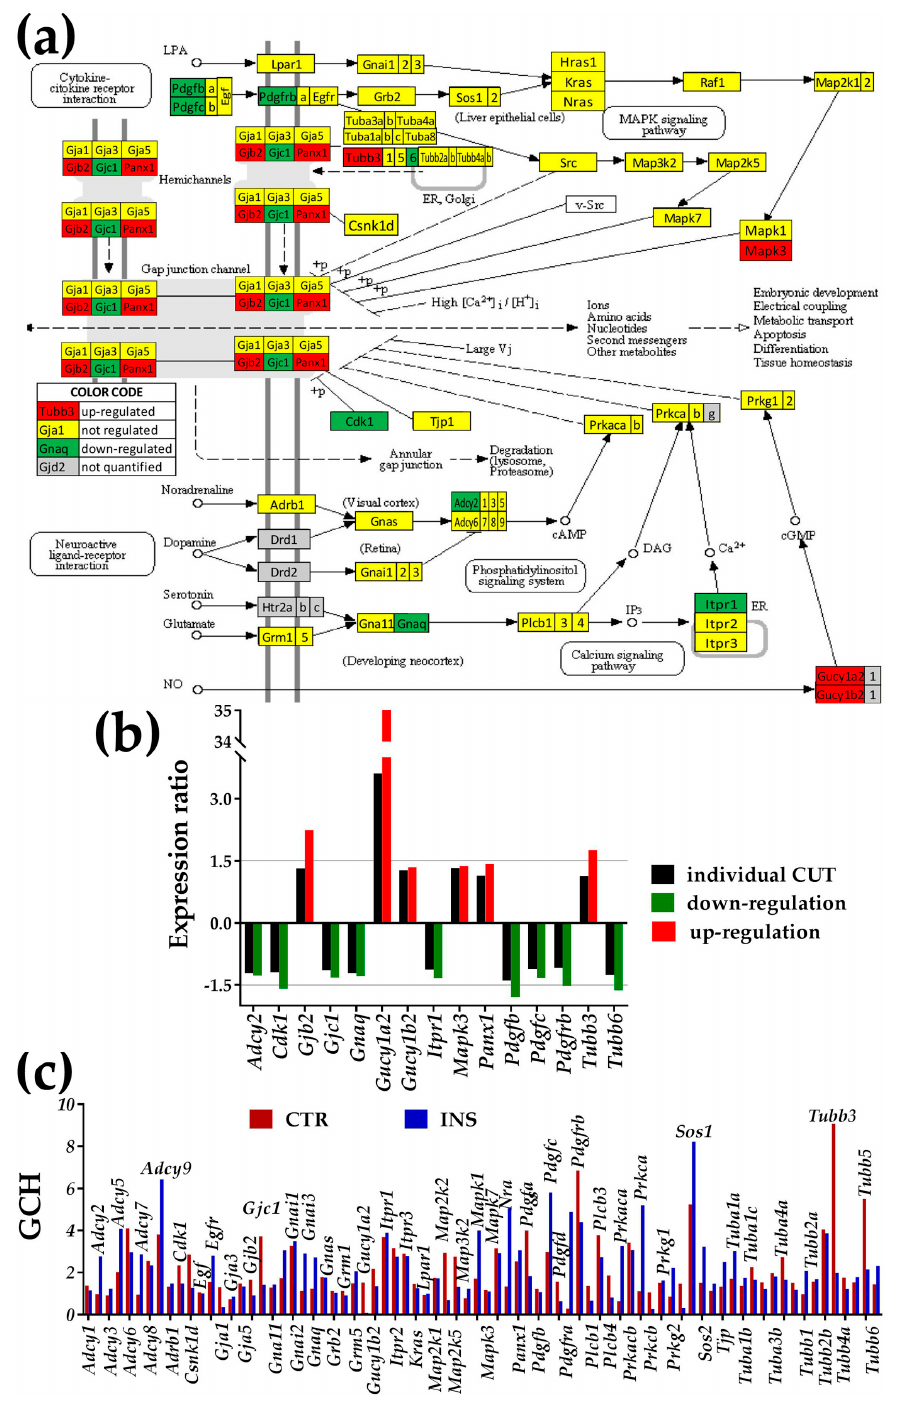
Figure 2. Presence of non-touching Oli-neu cells affects genes in the gap junction (GJ) pathway (modified from https://www.genome.jp/kegg-bin/show_pathway?mmu04540). (a) Regulation (up - red background, down – green background) of the interconnected genes within the GJ pathway. (b) Expression ratios and individual fold-change cut-offs (both negative for down-regulation) of the significantly regulated genes . (c) Gene Commanding Height (GCH) scores of the GJ genes in the two conditions. The most prominent gene in CTR astrocytes is Tubb3 (GCH = 9.07), while in INS cells it is Sos1 (GCH = 8.23). As illustrated in Fig. 1(c), considering the entire pathway, the median GCH increased by over 17% in INS with respect to CTR.